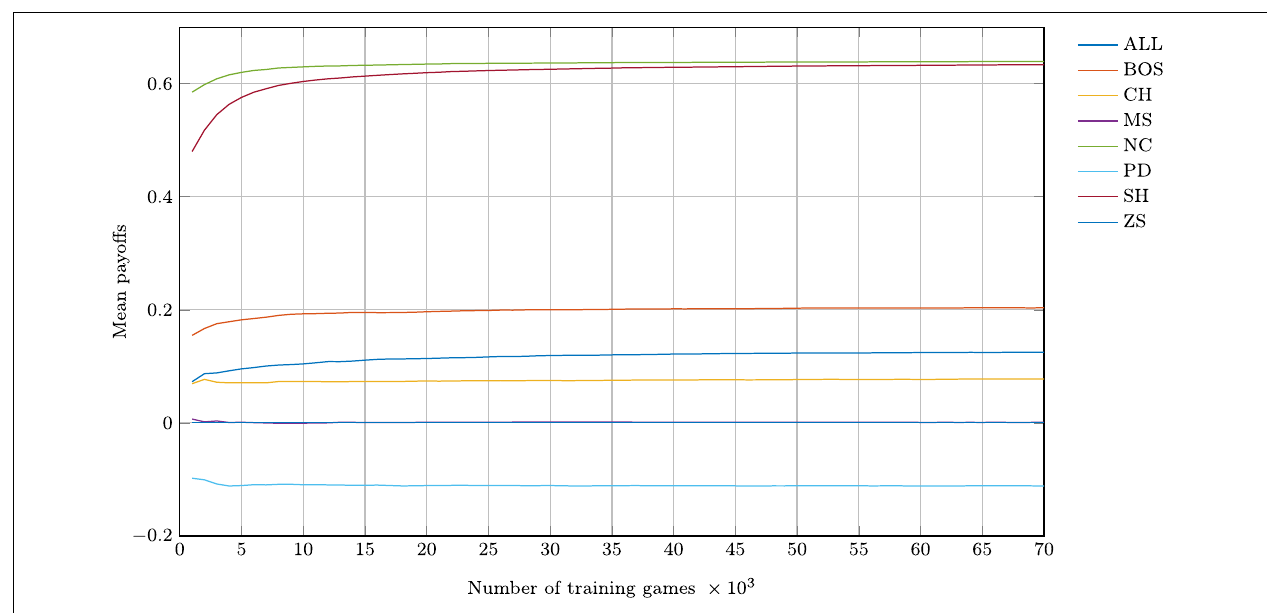
FIGURE 1 | Convergence of the simulations—mean payoffs as a function of the number of games played.